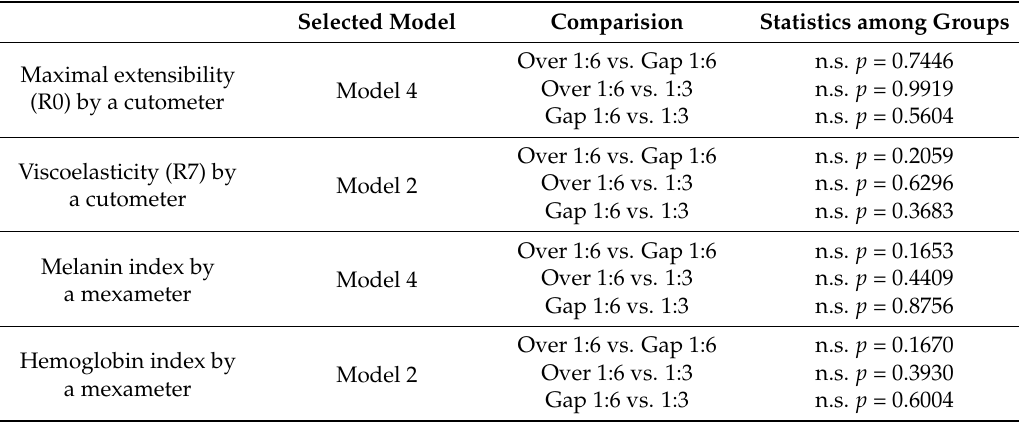
Table 4. Model selection and statistical